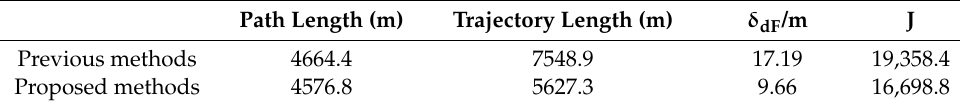
Table 5. Comparisons between previous method and the proposed method.